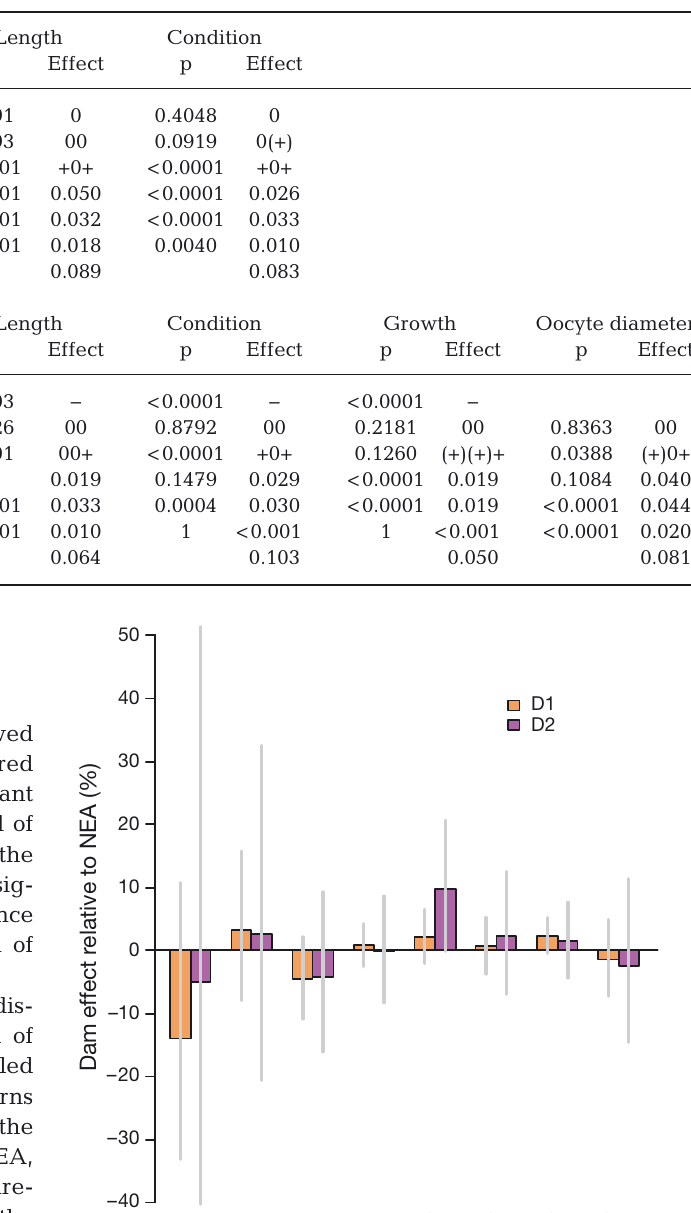
Table 2. Results of the statistical analyses with mixed models in Expt A. For fixed effects, ‘effect’ indicates the significance of individual factor levels: + stands for significant (p < 0.05) positive difference relative to the wild Northeast Arctic cod (NEA, for dam and sire group) or females (for sex); −: significant negative difference; (+): marginally significant (0.05 ≤ p < 0.10) positive difference; and 0: no significant difference. The order of dam groups is ‘D1, D2’ and sire groups is ‘CC, D1, D2’ (see Table 1 for descriptions of groups). For random effects, ‘effect’ is the corresponding standard deviation; residual standard deviation is shown for reference. Growth is measured as specific growth rate, with log(start weight) as an additional explanatory variable to account for growth declining with initial size (p < 0.0001)